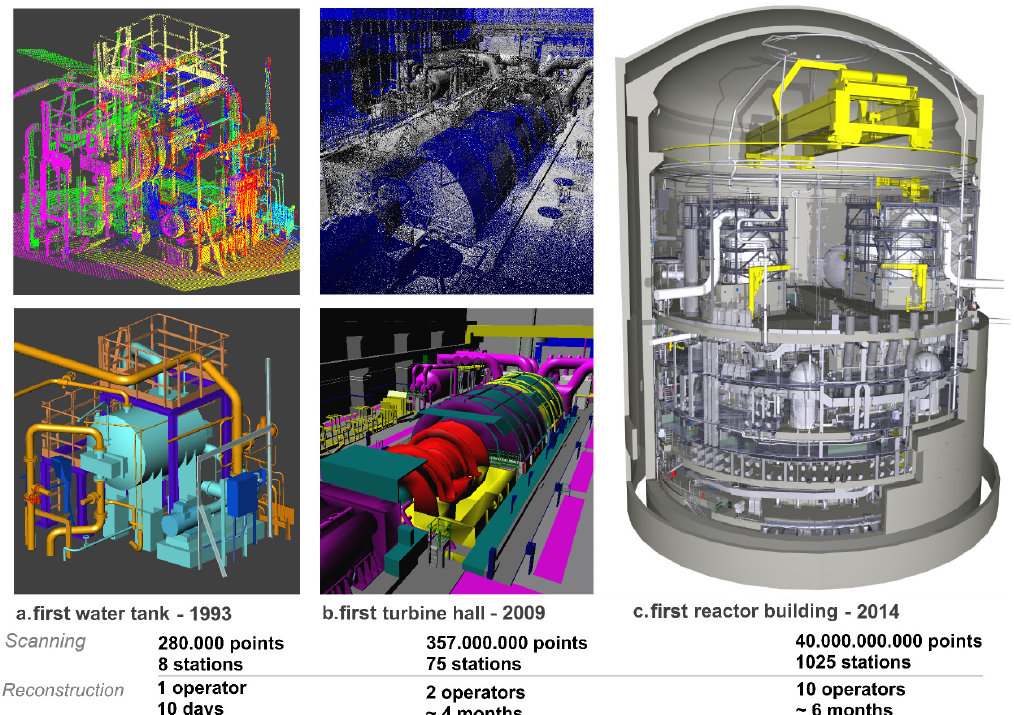
Figure 1: Review of 3 breakthroughs projects (1993-2014) of as-built reconstruction from laser scanning data of industrial facilities at